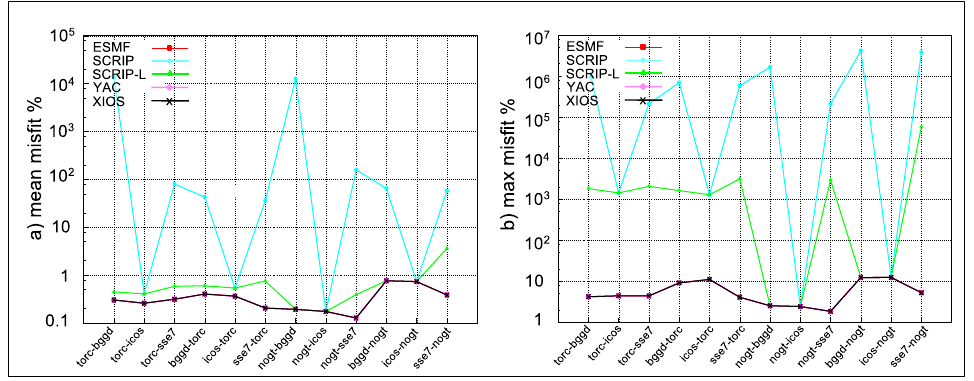
Figure 9. ( a ) mean and ( b ) maximum misfit for ESMF, SCRIP, SCRIP-L, YAC, and XIOS for the first-order conservative remapping with DESTAREA normalisation for the different pairs of grids for the harmonic function. For ESMF, nogt and torc are described with the unstructured format.